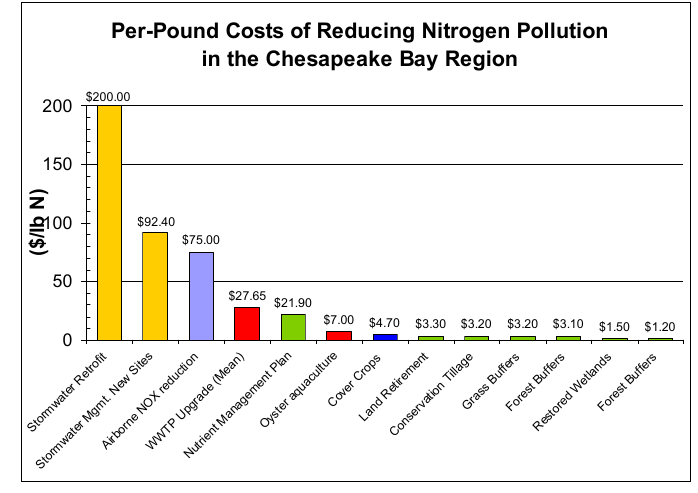
Figure 9. Costs (in 2010 dollars) to reduce nitrogen pollution in the Chesapeake Bay region [5,46]. Table 6. Nitrogen reduction costs by source [5,46–49].